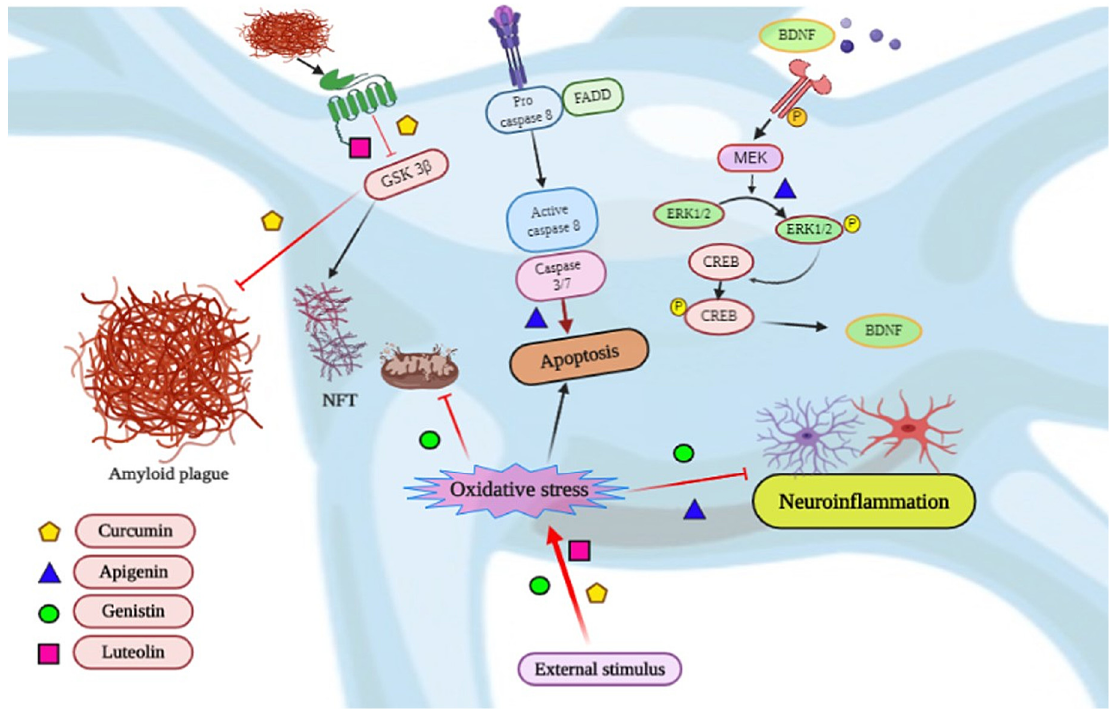
Figure 3. Schematic representation of the several mechanisms associated with Alzheimer’s Disease (AD) and their possible prevention by some phytochemicals. The main hallmarks of AD; amyloid plague and NFT are prevented by curcumin and luteolin via GSK 3 β pathway. Curcumin, genistin, and luteolin decreases the oxidative stress in the neuron. Neuroinflammation is also inhibited by genistin and apigenin. The pathway of apoptosis, activated in AD is blocked by the use of apigenin. Apigenin also activates BDNF/ERK/CREB pathway leading to neuronal survival.